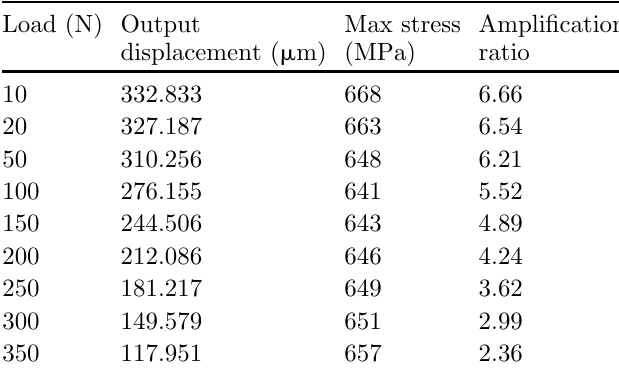
Table 4. Output displacement and ampli fi cation under different loads.